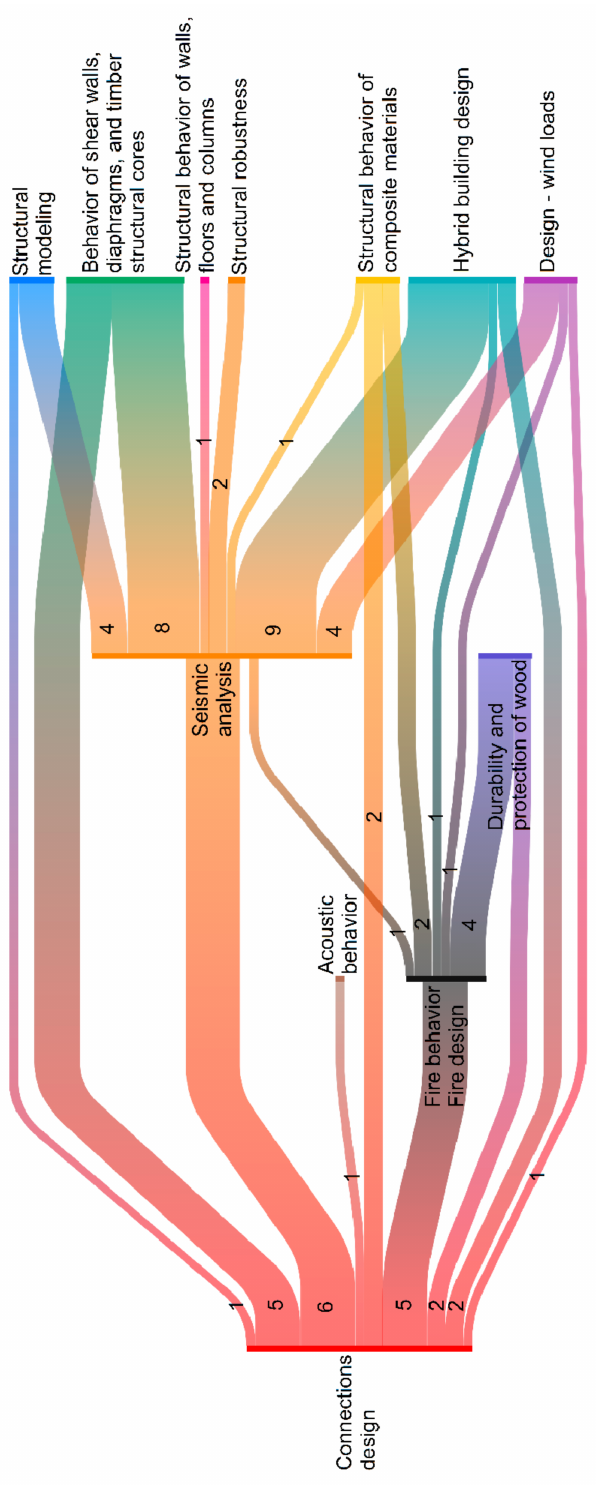
Figure 6. Relationships between the findings considered advances in the engineering and construction sciences category, based on the review of scientific articles on multi-storey timber buildings. It was also highlighted that among the 12 subcategories analyzed, the relationship with the highest intensity of co-occurrence was established between seismic analysis of timber buildings, and design of hybrid buildings (Coefficient C = 0.26), followed by a Coefficient C of 0.21 the relationship between seismic analysis and the behavior of